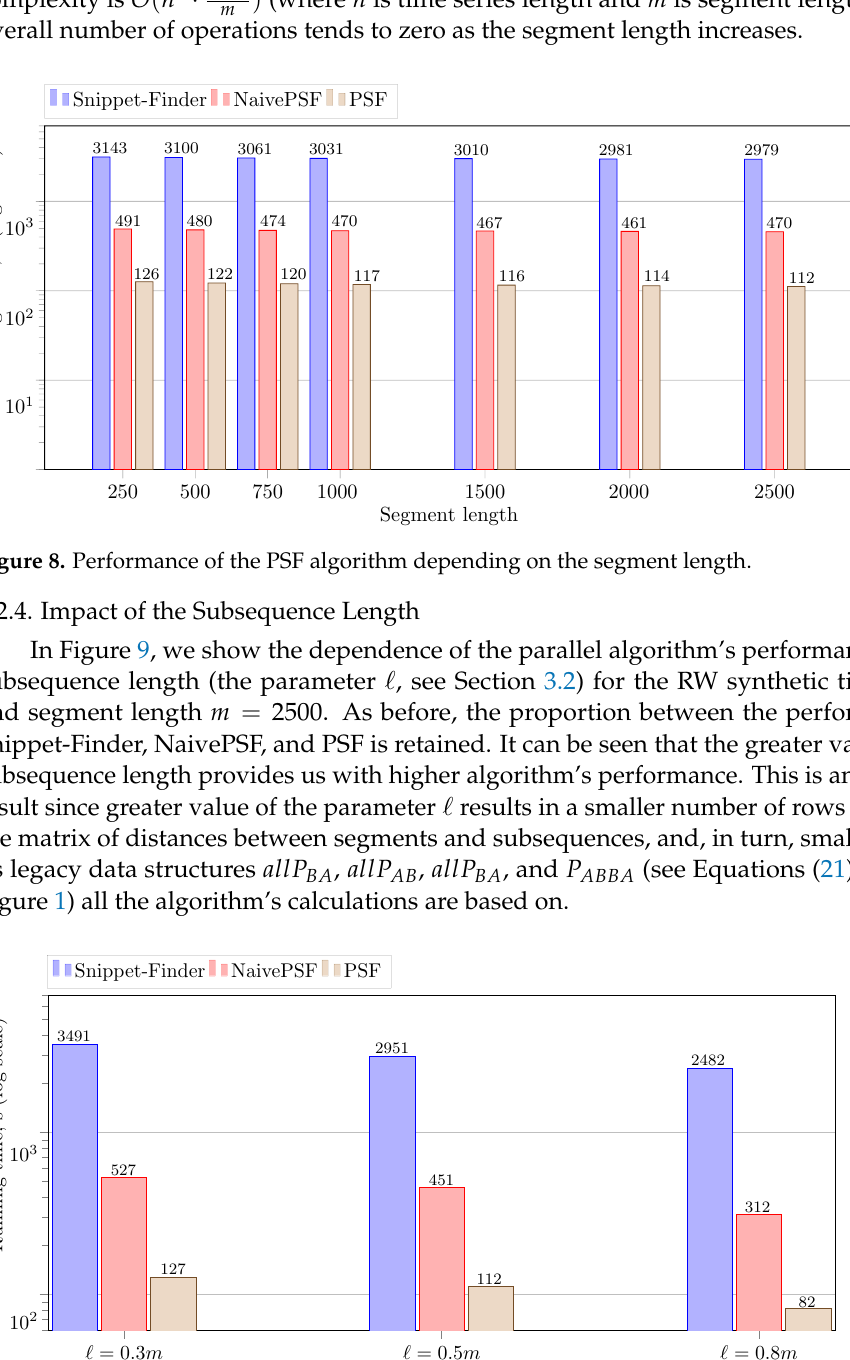
Figure 9. Performance of the PSF algorithm depending on the subsequence length